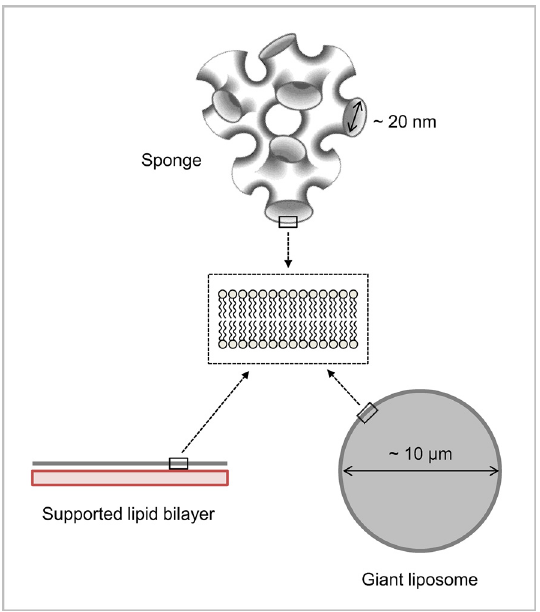
Fig 1. Various lipidic platforms used in this work to study the mobility and interaction of lipids and proteins within membranes. Supported lipid bilayers are formed by the Langmuir-Blodgett deposition technique, which allows the formation of asymmetrical membranes (inner and outer monolayers can be of different lipid compositions). Giant liposomes are free standing membranes of 10 – 100 μ m diameter. Sponge phases consist of interconnected bilayers forming aqueous channels whose diameter can be varied from 6 to 30